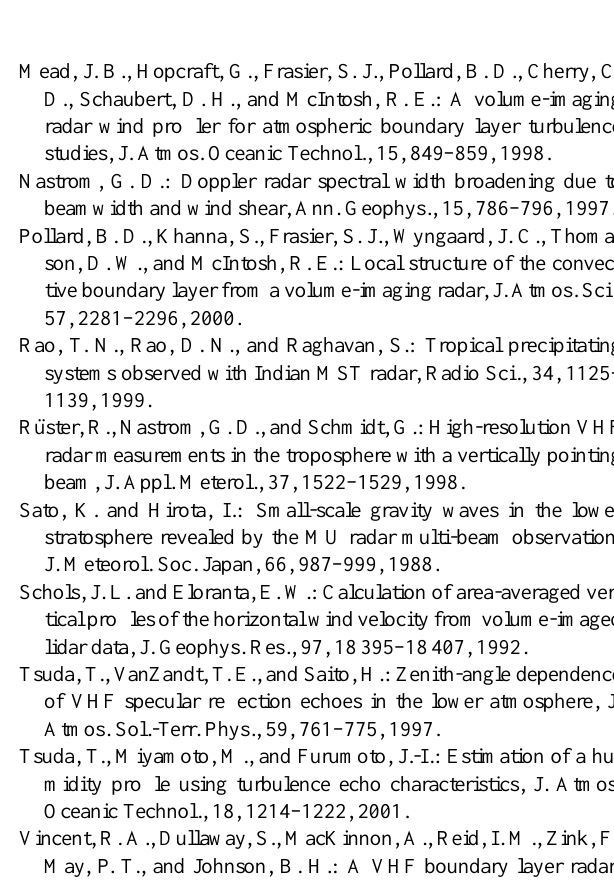
Fig. 14. Photographs from location × in Fig. 2 at (a) 13:20- (f) 13:40 JST 15 July 2002, showing (a, c, e, f) deep convection in the distance beyond a rice field and forest, and (b, d) Kelvin-Helmholtz